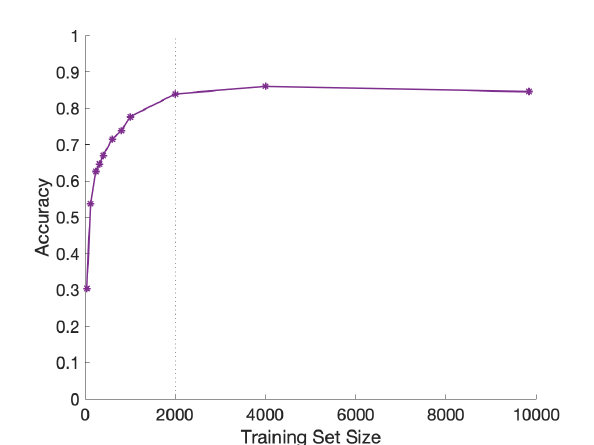
Figure 7. PointNet learning curve: maximum accuracy per training dataset size